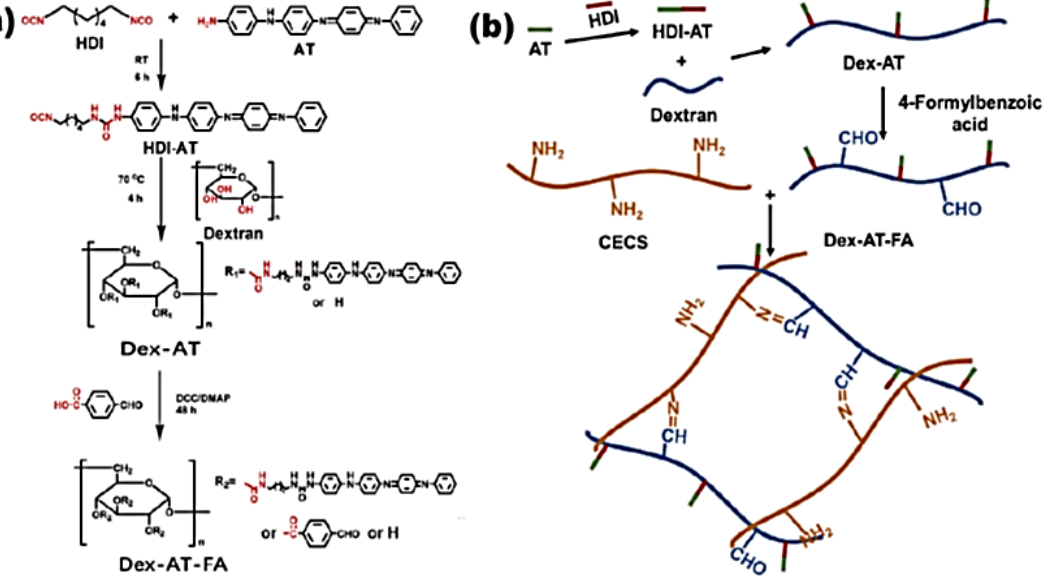
Figure 4. ( a ) Synthesis of dextran– graft –(aniline tetramer)– graft –(4-formylbenzoic acid), ( b ) Preparation of conducting self-healing hydrogel. Reproduced with permission [52].